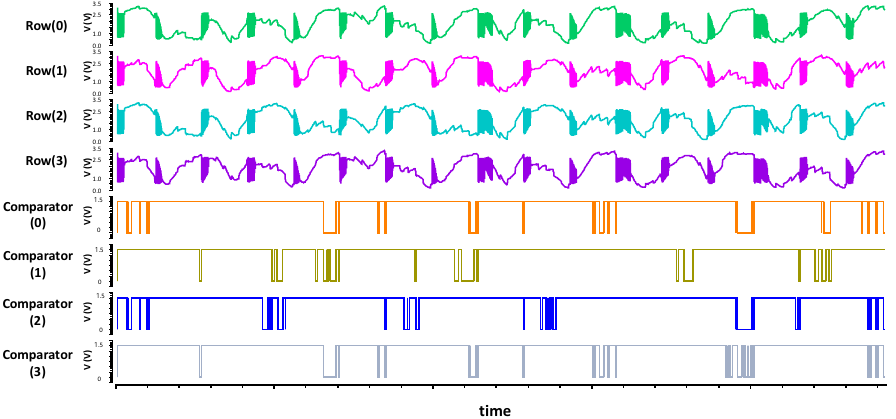
Figure 8. The output of the single-ended integrator.